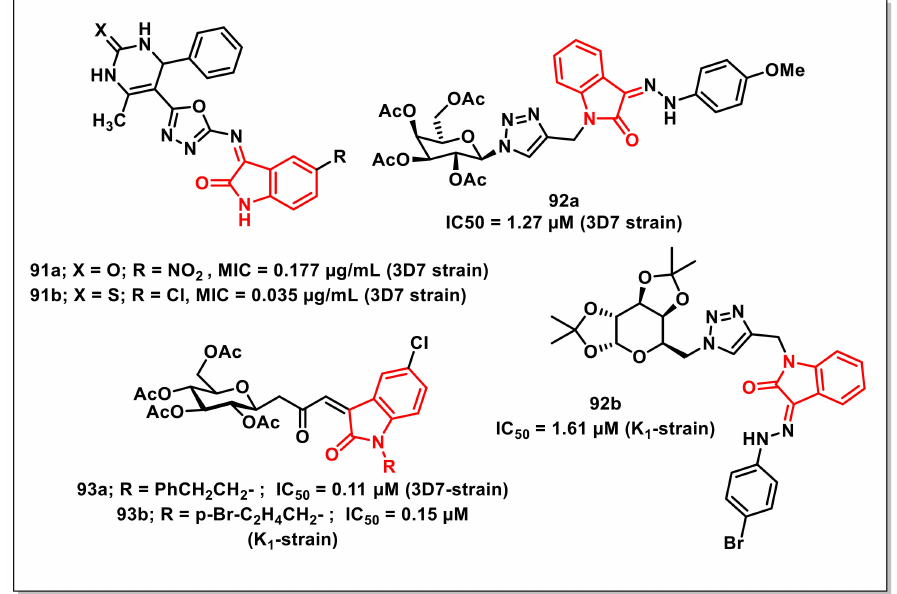
Figure 15. Schiff’s bases of Isatin with antiplasmodial